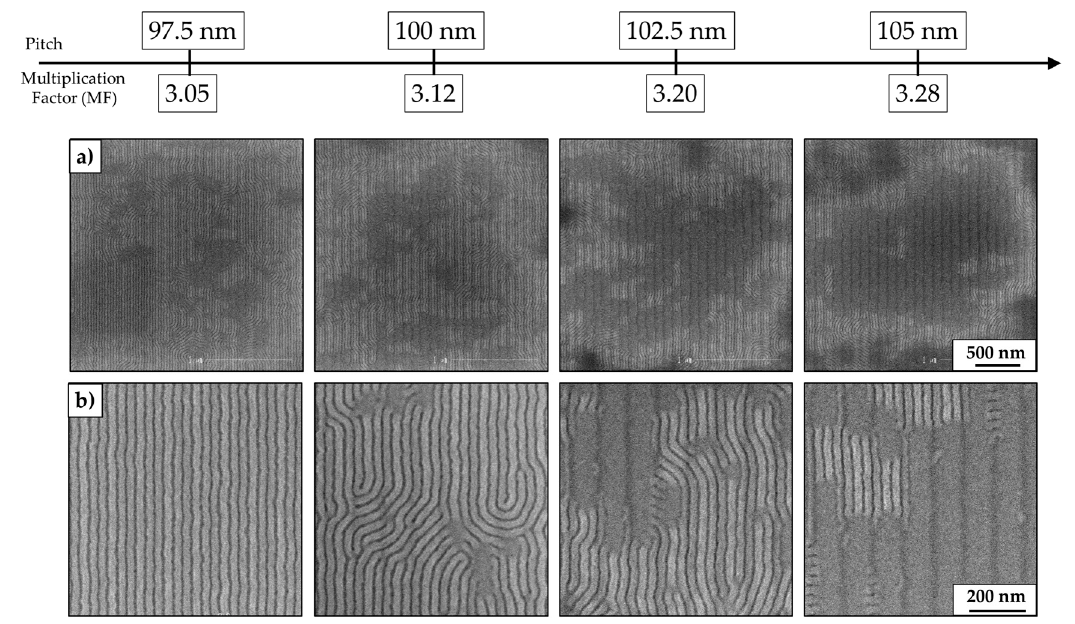
Figure 5. Representative CD-SEM images at low ( a ) et high ( b ) magnification, depicting the influence of the pitch dimension on the morphology of the BCP L32 for fixed CD ≈ 15 nm of TEOS lines. The multiplication factor (MF) is the result of Pitch/L 0 , where L 0 = 32 nm is the period of L32 on a flat